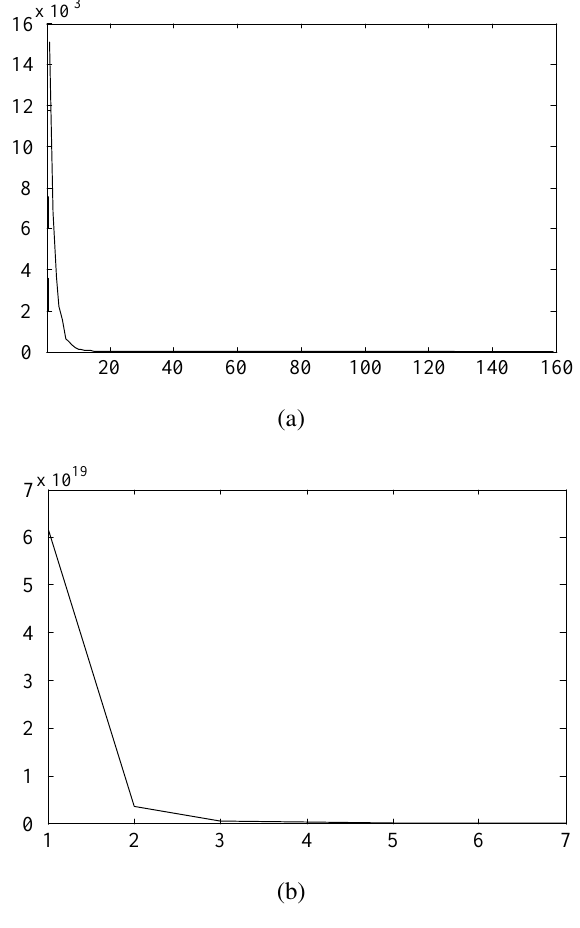
); (b) LDA ( (cid:21) L l l